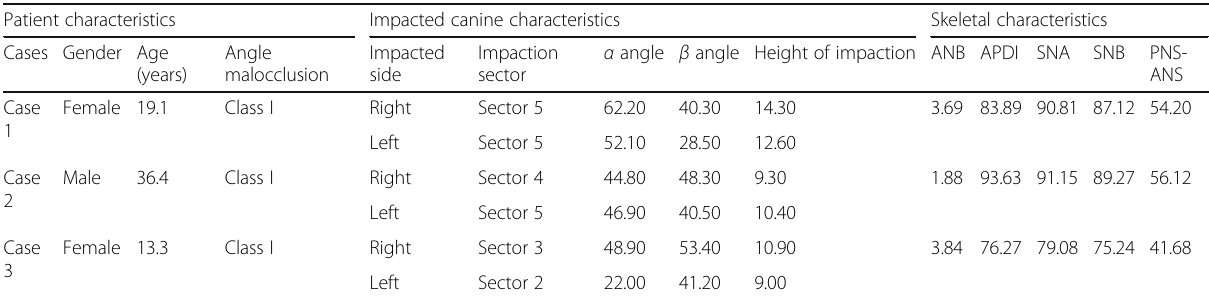
Table 1 Initial characteristics of the patients Patient characteristics Impacted canine characteristics Skeletal characteristics